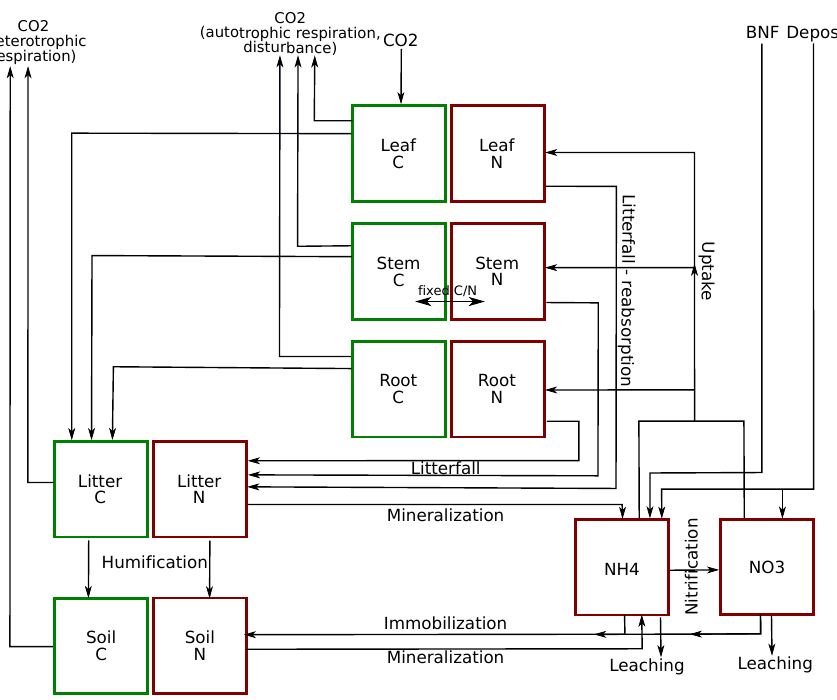
Fig. 1. Schematic representation of the carbon (green boxes) and nitrogen (red boxes) pools and fluxes in UVic-CN. The C cycle in the UVic ESCM is enhanced by adding a carbon litter pool. The nitrogen model is adapted from Gerber et al. (2010). Leaf, stem and root N content depend on the size of the C pools and fixed C/N ratios. The UVic ESCM inherent leaf, root and stem turnover rates are used to calculate litterfall with the only modification that N in leaves is partially reabsorbed before abscission. The litterfall goes first into the litter pool, which is partially decomposed and enters the NH 4 pool and part of it is humified and enters the soil N pool. The soil N pool is mineralised and adds to the NH 4 pool. Ammonium is turned into NO − via nitrification. Ammonium and NO − can be immobilised by the soil pool. Both of the 3 3 inorganic N species can be leached via runoff or taken up by plants. The plant uptake is set to meet the PFT’s requirement to achieve at least the minimum N